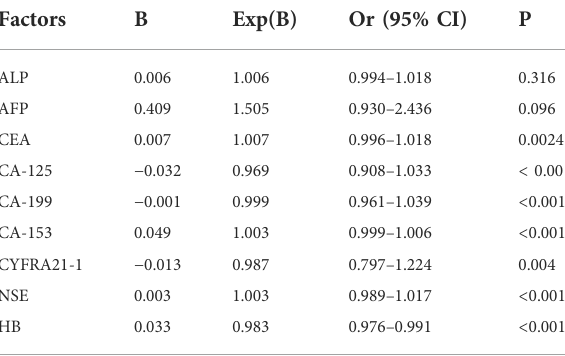
TABLE 3 Risk factors for elderly patients with liver metastasis of lung cancer.